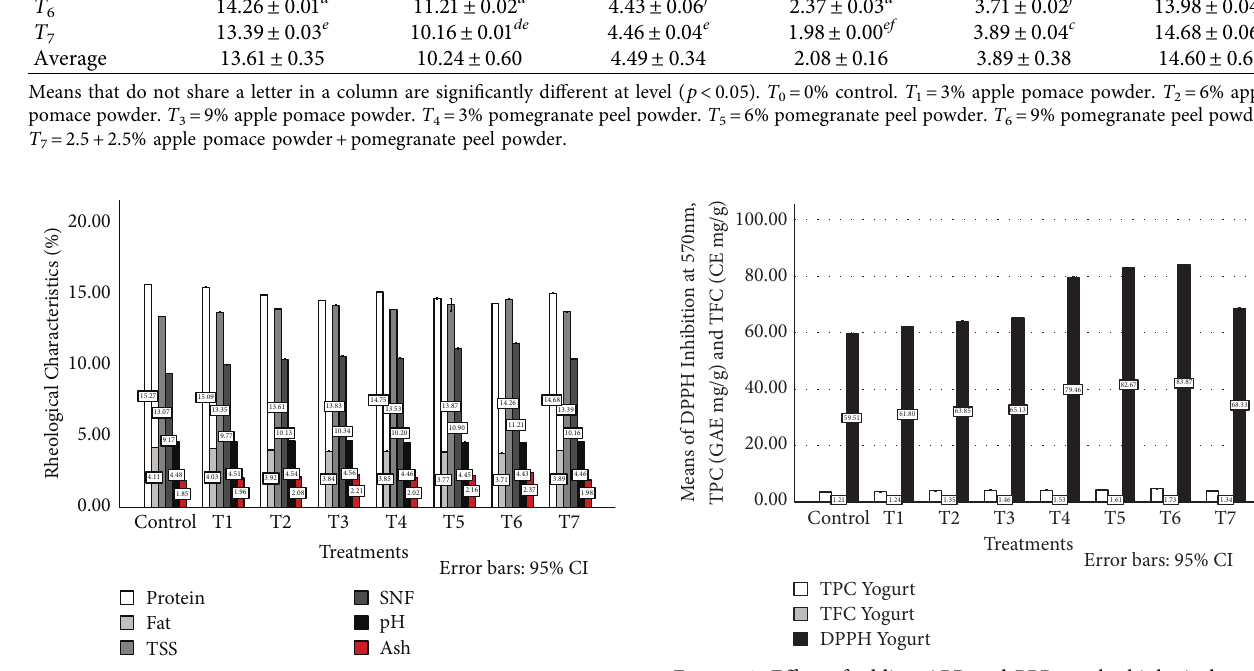
Figure 2: Effect of adding APP and PPP on the rheological properties of yogurt. Table 6: Effect of adding apple pomace powder and pomegranate peel powder on the bioactive profile of yogurt. Values in mean column are given in (mean ± SD).